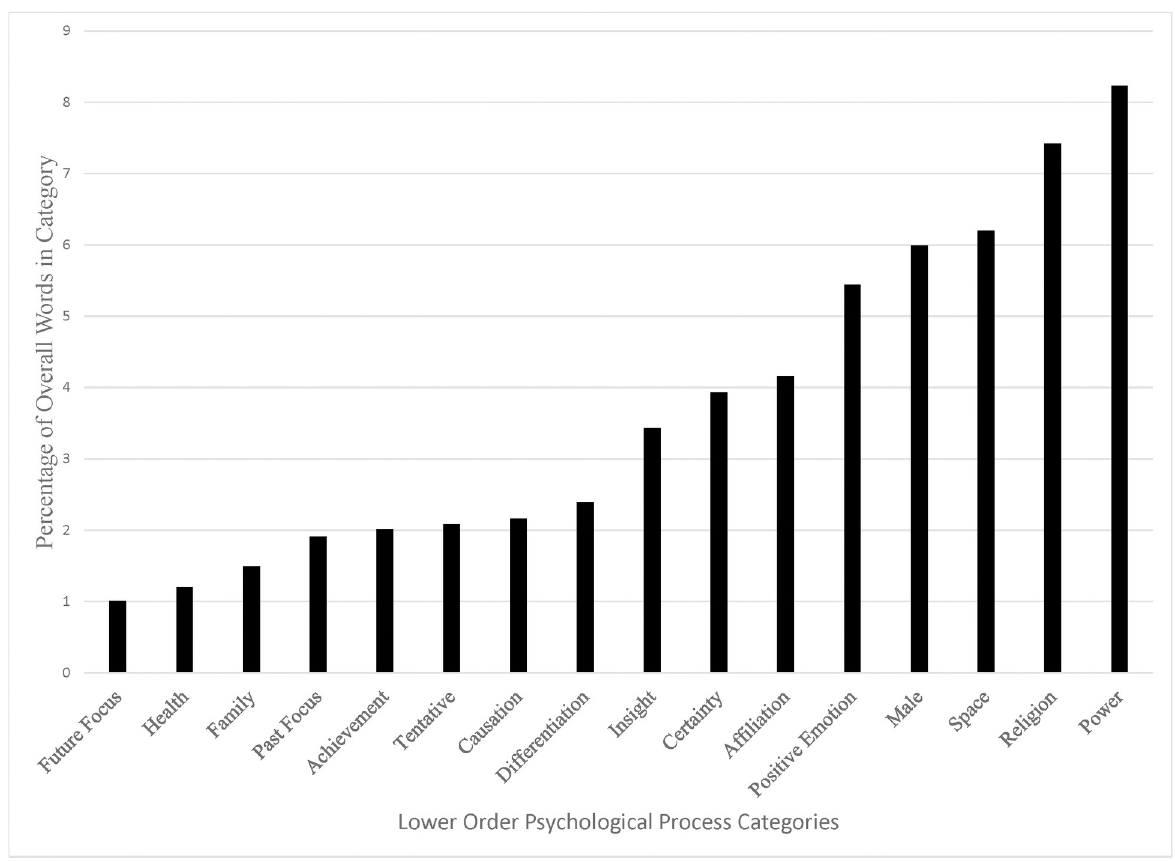
Fig 3. Percentage of word frequency for each of the LIWC lower order psychological process